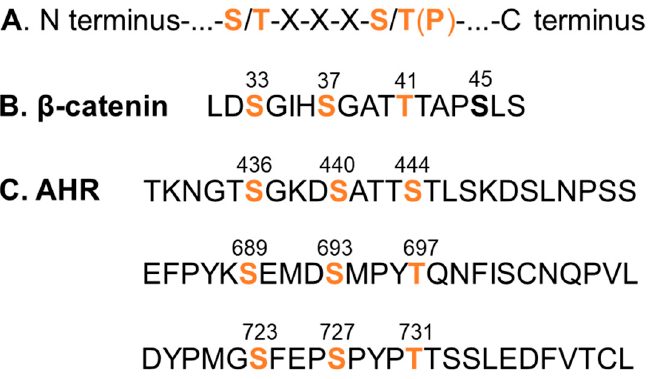
Figure 1. GSK3 β phosphorylation sites. ( A ) GSK3 β phosphorylation consensus sequence. ( B ) GSK3 β phosphorylation sites of β -catenin. ( C ) Three putative GSK3 β phosphorylation sites of the human AHR (amino acid 1-848) which show best match to the consensus sequence. The numbers indicate the amino acid locations of the primary sequence. Orange font represents the serine and threonine sites for GSK3 β phosphorylation. S45 (bold) of β -catenin represents the priming site of casein kinase 1. Phosphorylation of the priming site is necessary for GSK